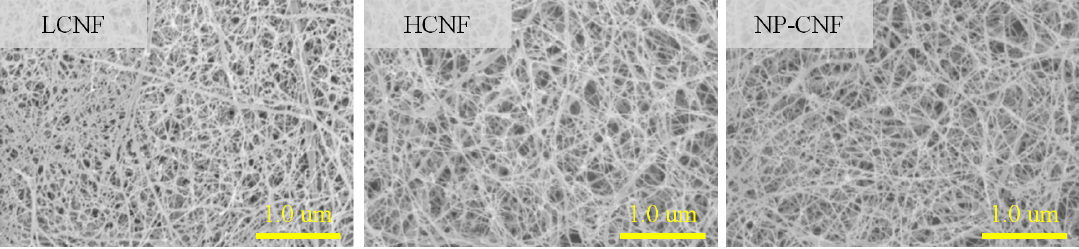
Figure 1. Morphological characteristics of LCNF, HCNF, NP-CNF.